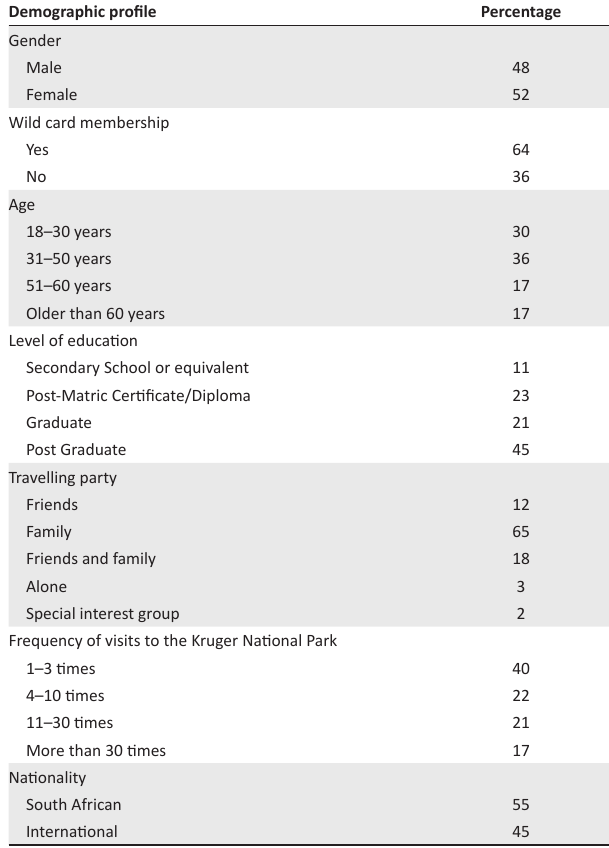
TABLE 1: Demographic profiles of